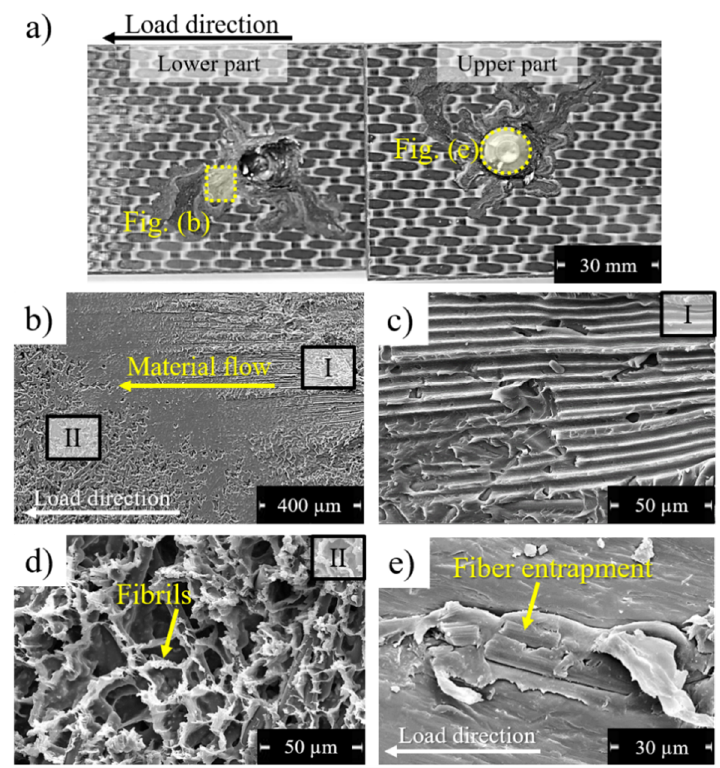
Figure 16. Typical fracture surface of friction-riveted joint. ( a ) General overview of the overlapped area from the lower and upper composite parts. ( b ) Squeezed composite at the surface of the lower composite part, showing the adhesive failure of the reconsolidated composite layer; ( c ) Impressions of fiber tearing in the reconsolidated composite layer; ( d ) Polymer fibrils, indicating ductile fracture of the reconsolidated composite layer. ( e ) Surface of the rivet tip, showing broken fiber entrapment. (Joining parameters—RS: 15,000 rpm, DF: 7.5 mm, FF: 10 kN, CP: 0.2 MPa).